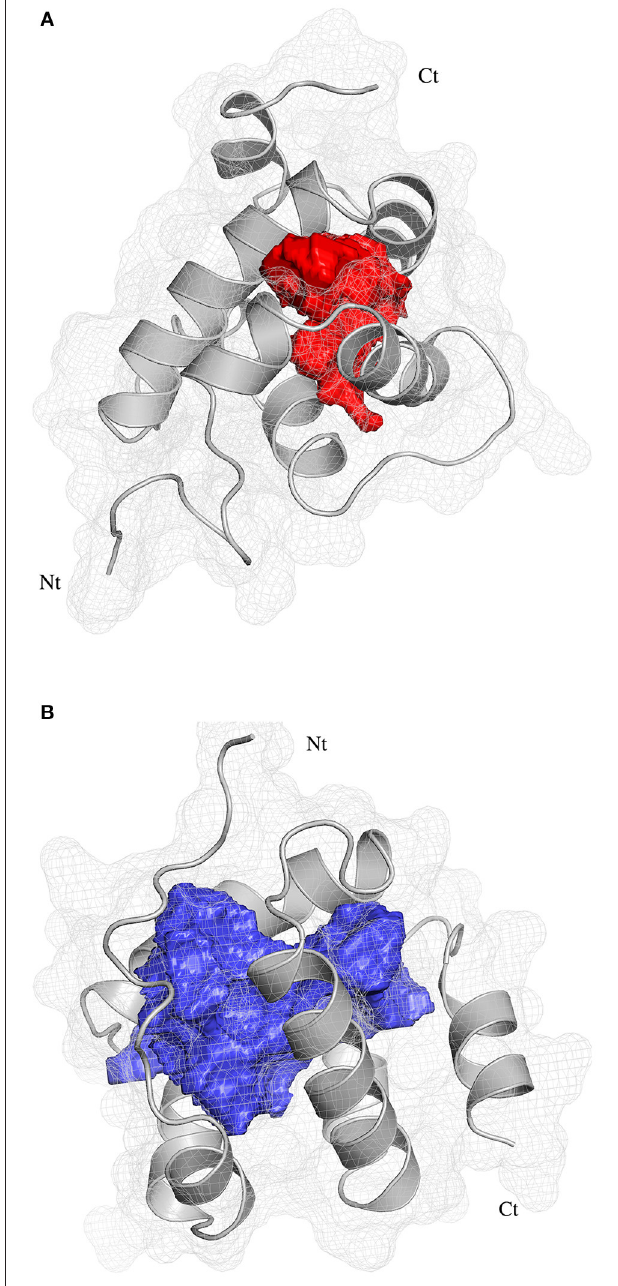
FIGURE 6 | Position of binding pockets in EbraCSP8 and EscrCSP8a. (A) Position of binding pockets in EbraCSP8; (B) Position of binding pockets in